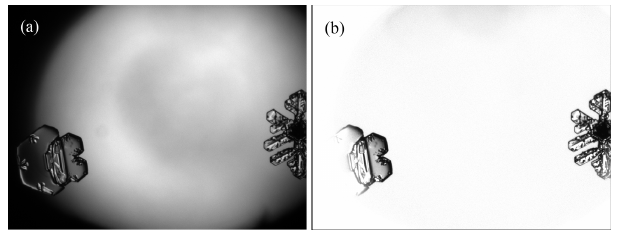
Figure 6. Examples of ice particles flagged as“on-border” (on the right side of the image) and “in-darkregion” (on the left side of the image). The original image (a) and the image after background re- moval (b) are